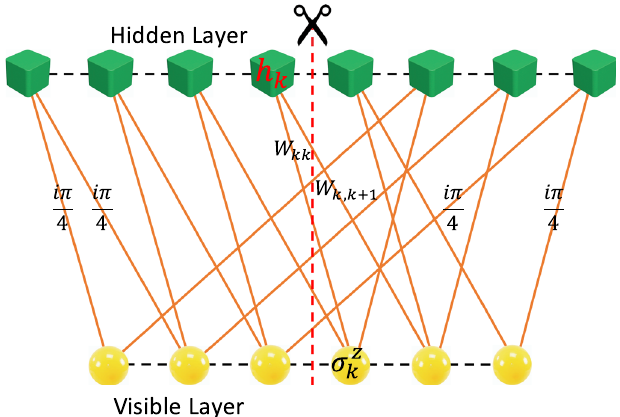
FIG. 3. An illustration of the constructed 1D neural-network state with a maximal volume-law entanglement entropy. This restricted Boltzmann machine has N visible and ⌊ ð 3 N Þ = 2 ⌋ − 1 hidden neurons. For 1 ≤ k ≤ N − 1 ( N ≤ k ≤ ⌊ ð 3 N Þ = 2 ⌋ − 1 ), the k th hidden neuron is connected to two visible neurons at sites k and k þ 1 ( k þ 1 − N and k þ 1 − ⌈ N= 2 ⌉ ) with connection weight parameters equal to ð i π Þ = 4 . The on-site potentials for the visible neurons are chosen to be zero, a k ¼ 0 ( ∀ k ). For the hidden neurons, b k is chosen as b k ¼ − ½ð i π Þ = 4 (cid:2) ( 1 ≤ k ≤ N − 1 ) and b k ¼ ½ð π i Þ = 2 (cid:2) ( N ≤ k ≤ ⌊ ð 3 N Þ = 2 ⌋ − 1 ). The scissors show a cut of the system into two subsystems ( A and B ) with equal sizes, and for this bipartition, the Rényi entropy is S A α ¼ ⌊ N= 2 ⌋ log 2 , proportional to the system size. This is also the maximal amount of entropy one can have for a system with N